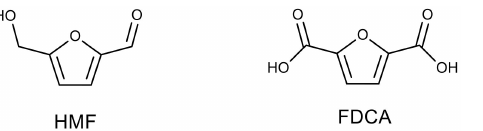
Figure 19. The structures of 2,5-furandicarboxylic acid (FDCA) and 5-hydroxymethylfurfural